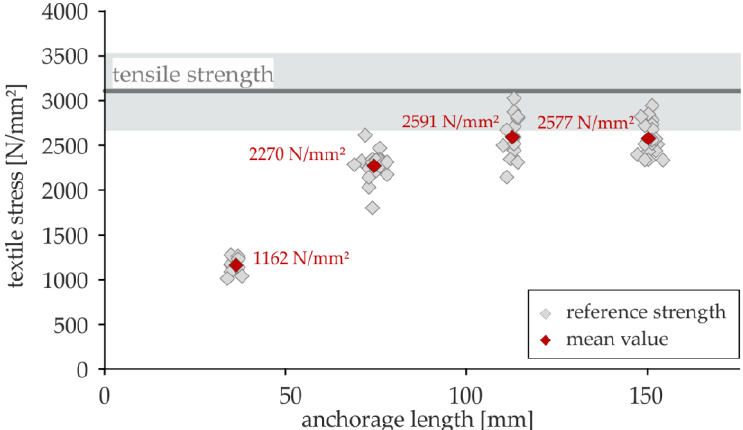
Figure 4. Maximum reached stresses in static double-sided textile pull-out (DPO) tests with different anchorage lengths.